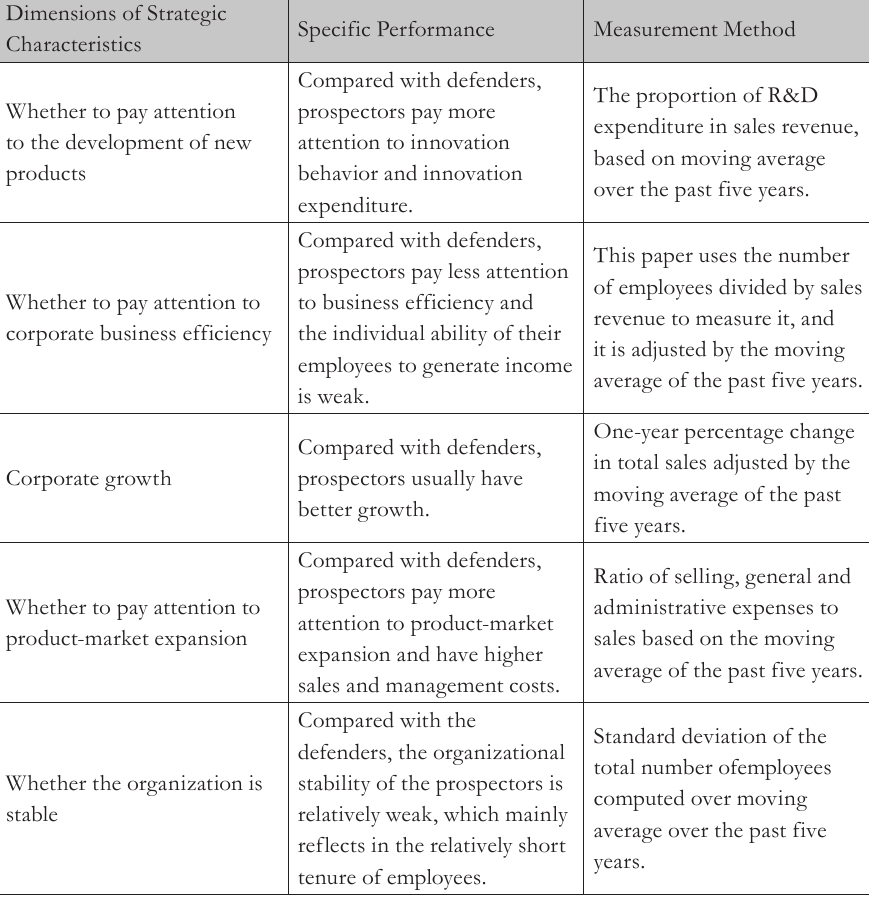
Tab. 1 – The characteristics and measurement of business strategy. Source: own